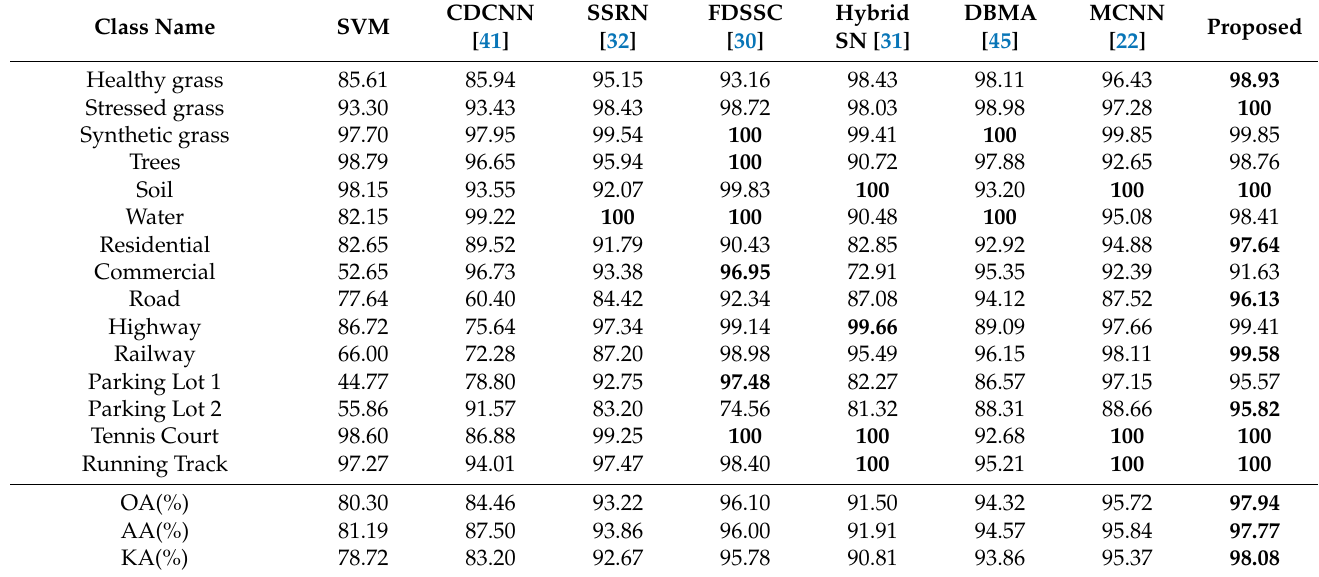
Table 8. Classification result of different methods on the HU